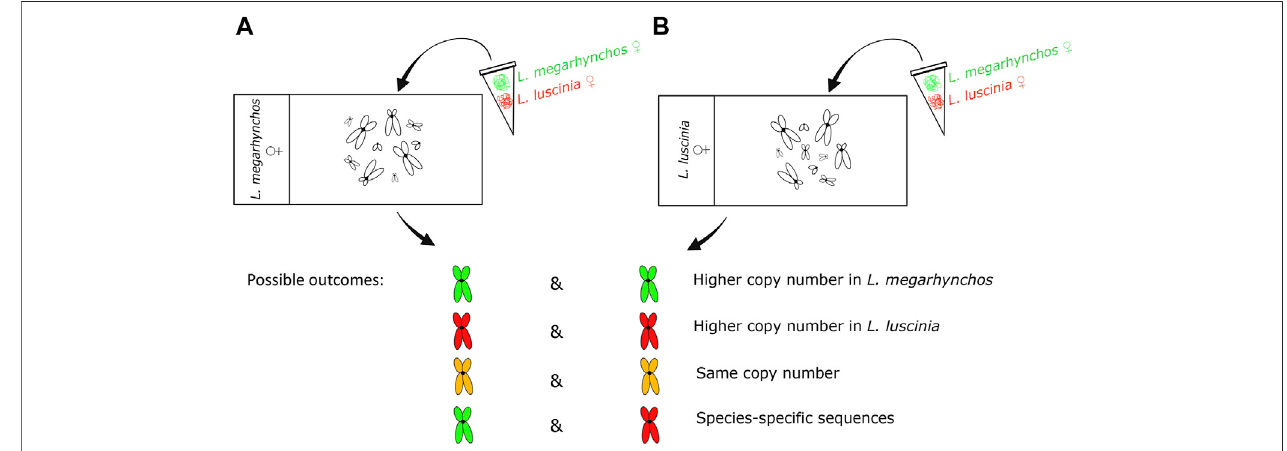
FIGURE 1 | Design and possible outcomes of the interspeci fi c comparative genomic hybridization (CGH) experiment. The genomic probe of the common nightingale ( L. megarhynchos ) (stained green) and the thrush nightingale ( L. luscinia ) (stained red) were hybridized on the metaphase of common nightingale (A) and thrushnightingale (B) .Whereasinthe fi rstthreeoutcomesthesamerepetitivesequencesexistinbothspeciesandthecolorre fl ectsdifferencesintheircopynumber,the last outcome points to the existence of species-speci fi c repetitive